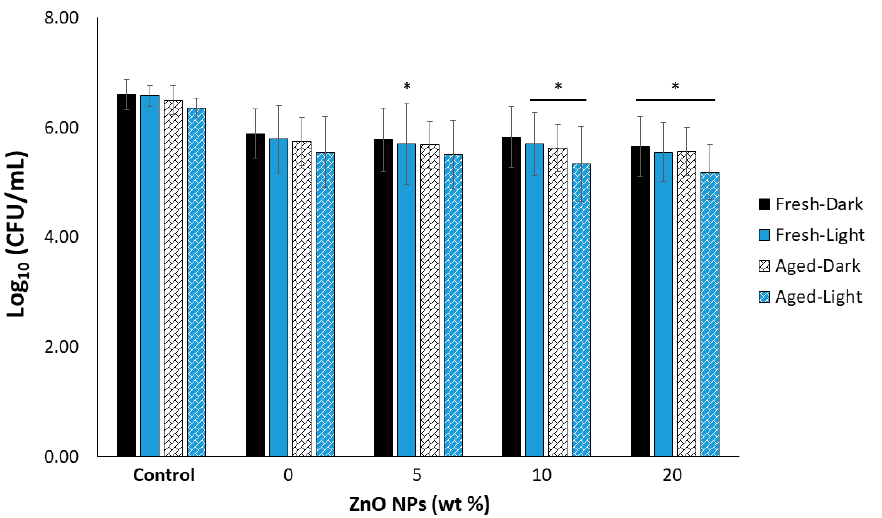
Figure 6. The CFU/mL count as a function of ZnO NP concentration, aging in 37 °C water, and application of light. * Indicates a detected decrease from the S. mutans control under similar aging and light conditions (* p < 0.05; n = 9).